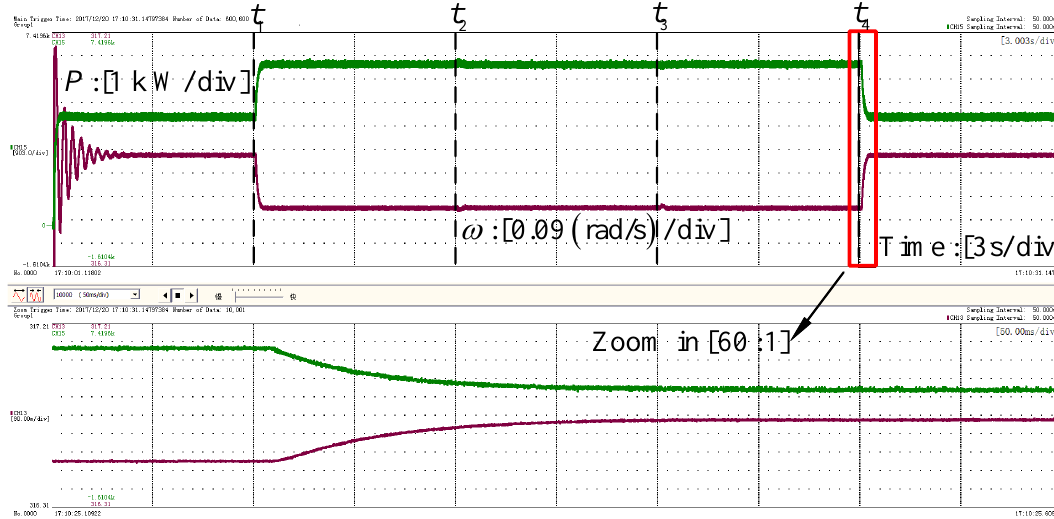
Figure 16. Experiment results: Angular frequency reference and active power at the PCC.